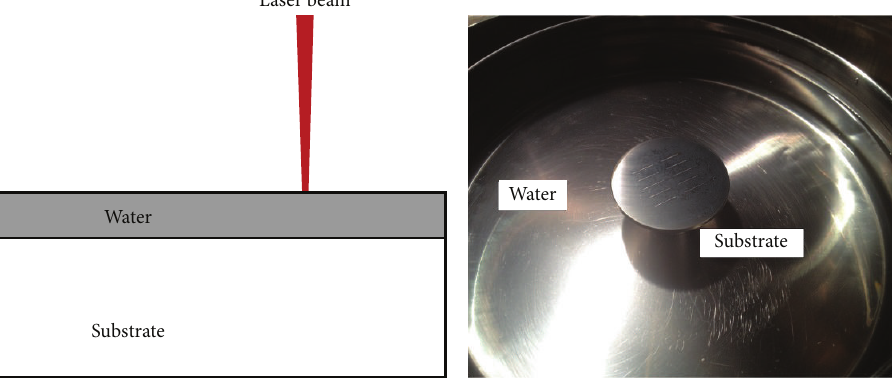
Figure 2: Immersed specimen for underwater experiment.